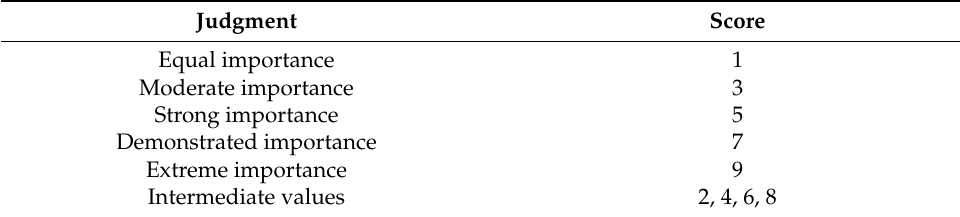
Table A1. Traditional judgment scores in AHP (Menon and Ravi 2022).